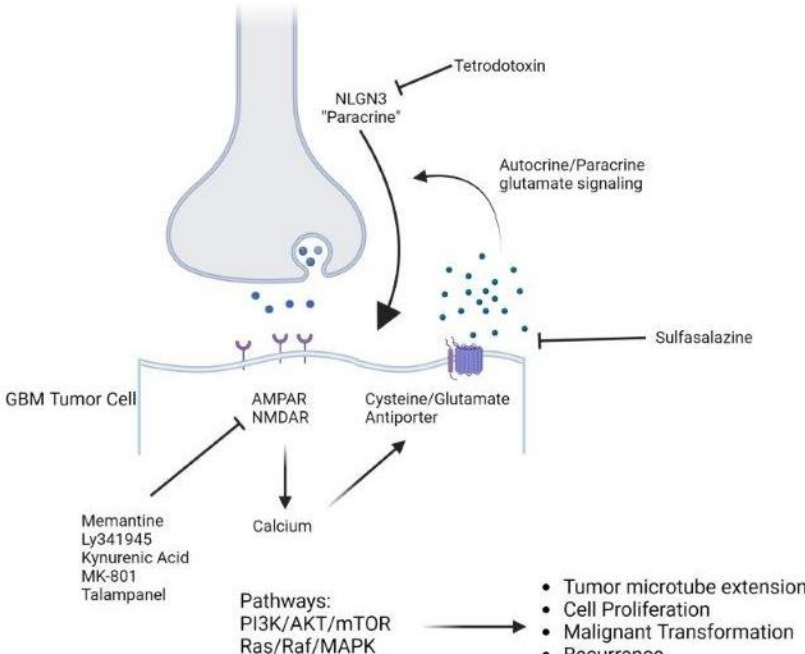
Figure 1. Schematic of a neuron-glioma synapse demonstrating synaptic and non-synaptic avenues of excitatory signaling as well as inhibitors thereof. GBM- glioblastoma; NLGN3-